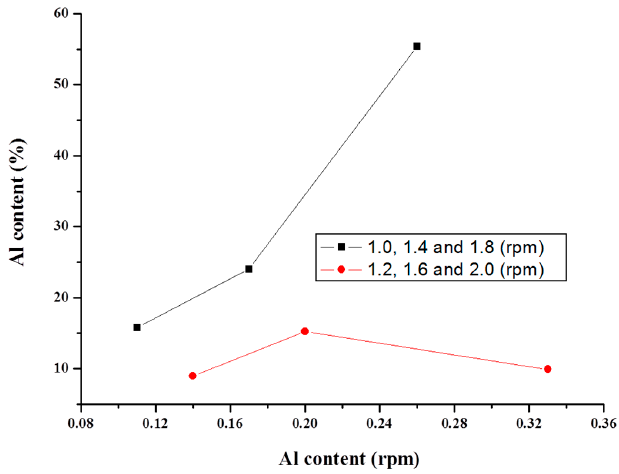
Figure 5. Al content [EDS vs. set rpm].